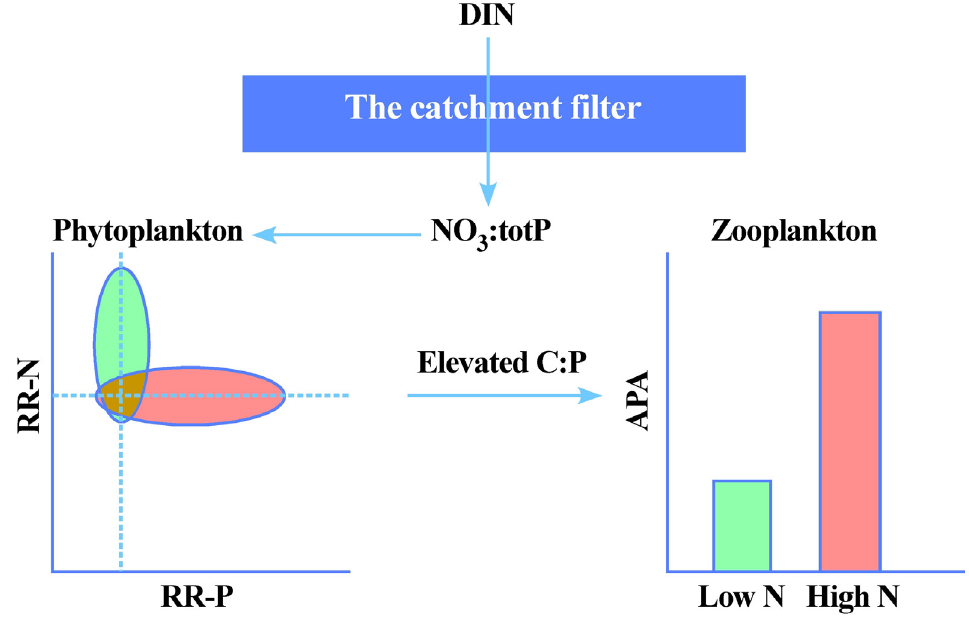
Figure 5. The potential effects of DIN-deposition and catchment on autotroph nutrient limitation and grazer P-limitation in lakes receiving low (green) and high (red) DIN-deposition. The NO :TP ratio reflects DIN-inputs and catchment properties and 3 processes, and will determine whether phytoplankton displays a positive relative response towards single nutrient additions in bioassays, either N-addition (RR-N > 1), or P-addition (RR-P > 1) (Modified from [17]). Intensified P-limitation will cause reduced food quality for grazers in terms of elevated C:P-ratios in their phytoplankton food, which is manifested as elevated alkaline phosphatase activity (APA) (modified from